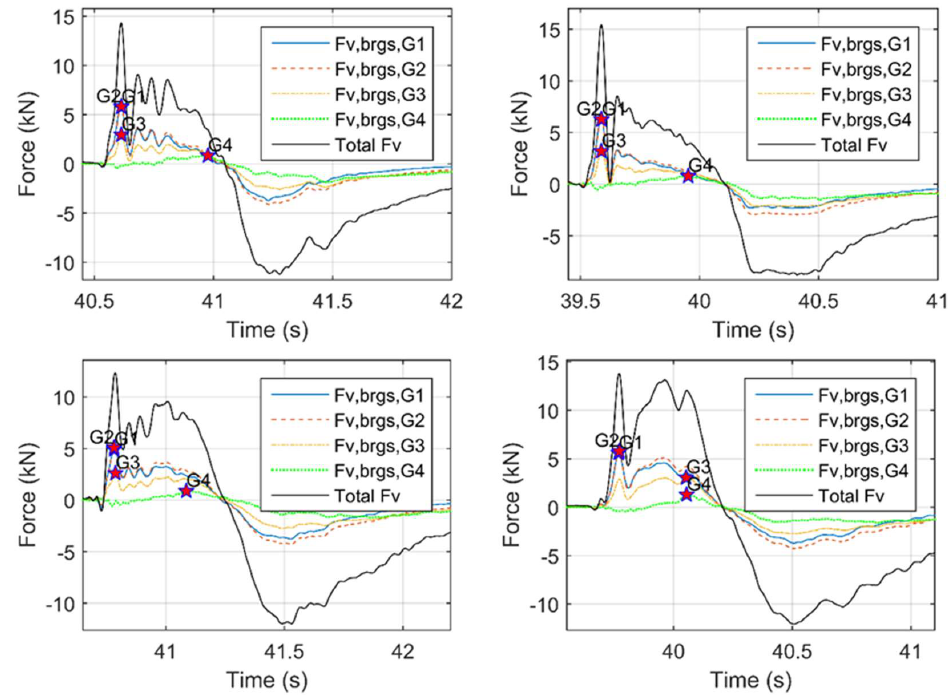
Figure 14. Vertical forces in individual bearings of the deck with cross-frames ( top ) and the deck with solid diaphragms ( bottom ), for H = 1.0 m ( left ) and H = 1.30 m ( right )